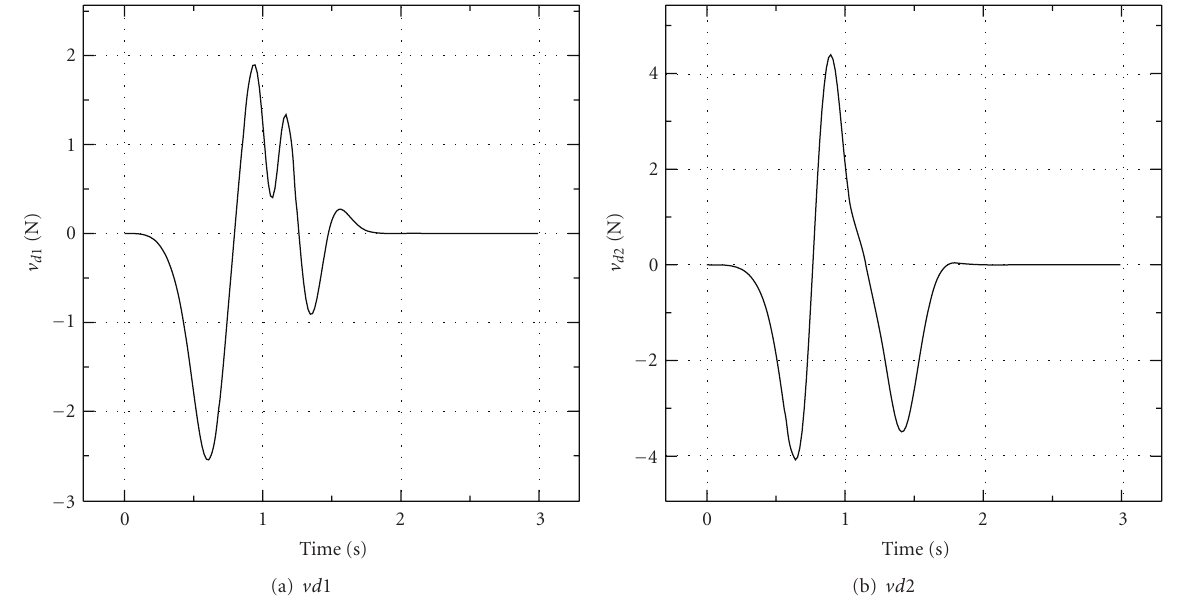
Figure 6: Transient responses of the ILC term v d = ( v d 1 , v d 2 ) T .